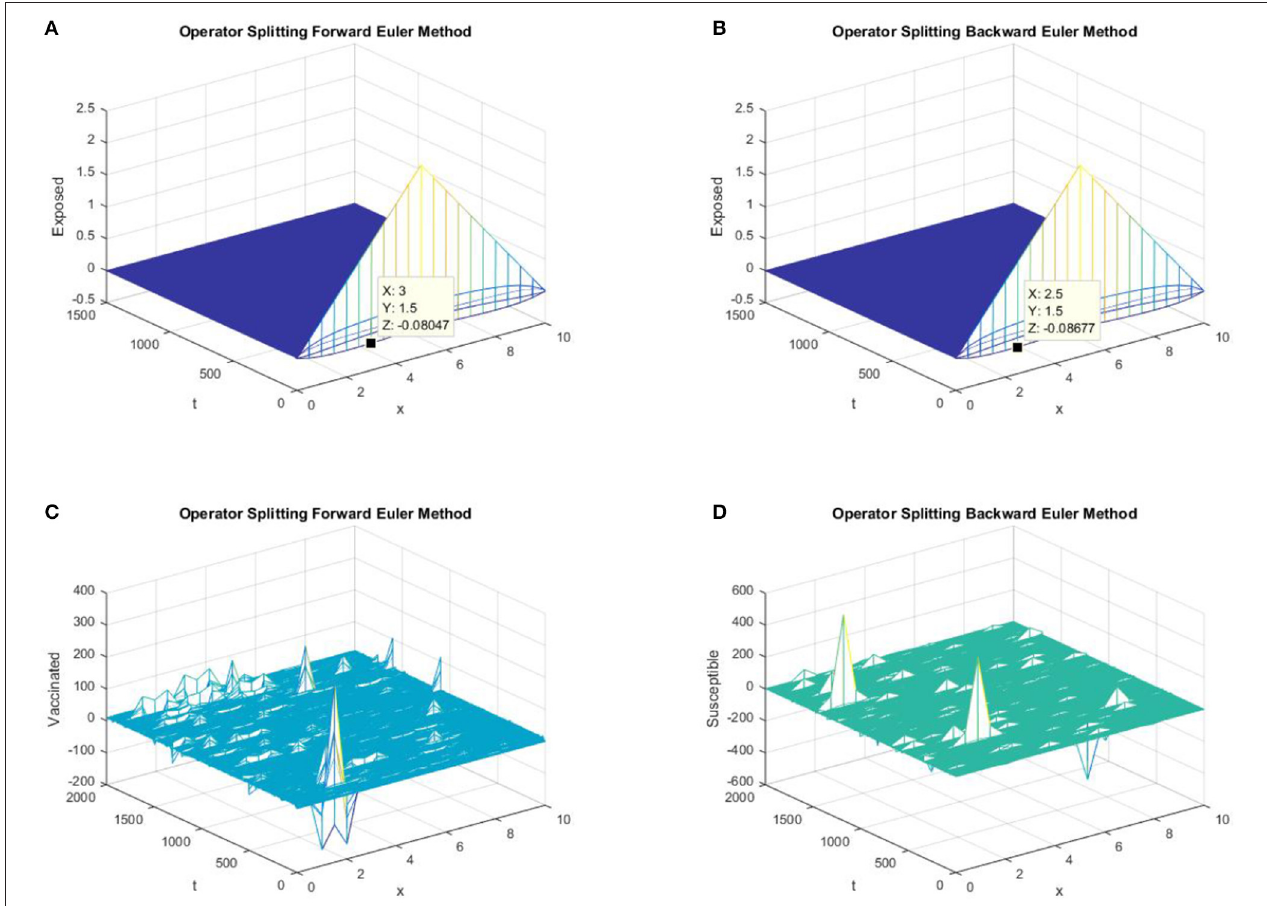
FIGURE 3 | (A) The forward Euler FD operator splitting method is used to simulate the graph of exposed persons for the DFE point at h = 0.5, λ 1 = 0.3. (B) The backward Euler FD operator splitting method is used to simulate the graph of susceptible persons for the DFE point at h = 0.5, λ 1 = 0.3. (C) The forward Euler FD operator splitting method is used to simulate the graph of susceptible persons for the DFE point at h = 0.5, λ 1 = 0.4. (D) The backward Euler FD operator splitting method is used to simulate the graph of susceptible persons for the DFE point at h = 0.5, λ 1 = 0.4.